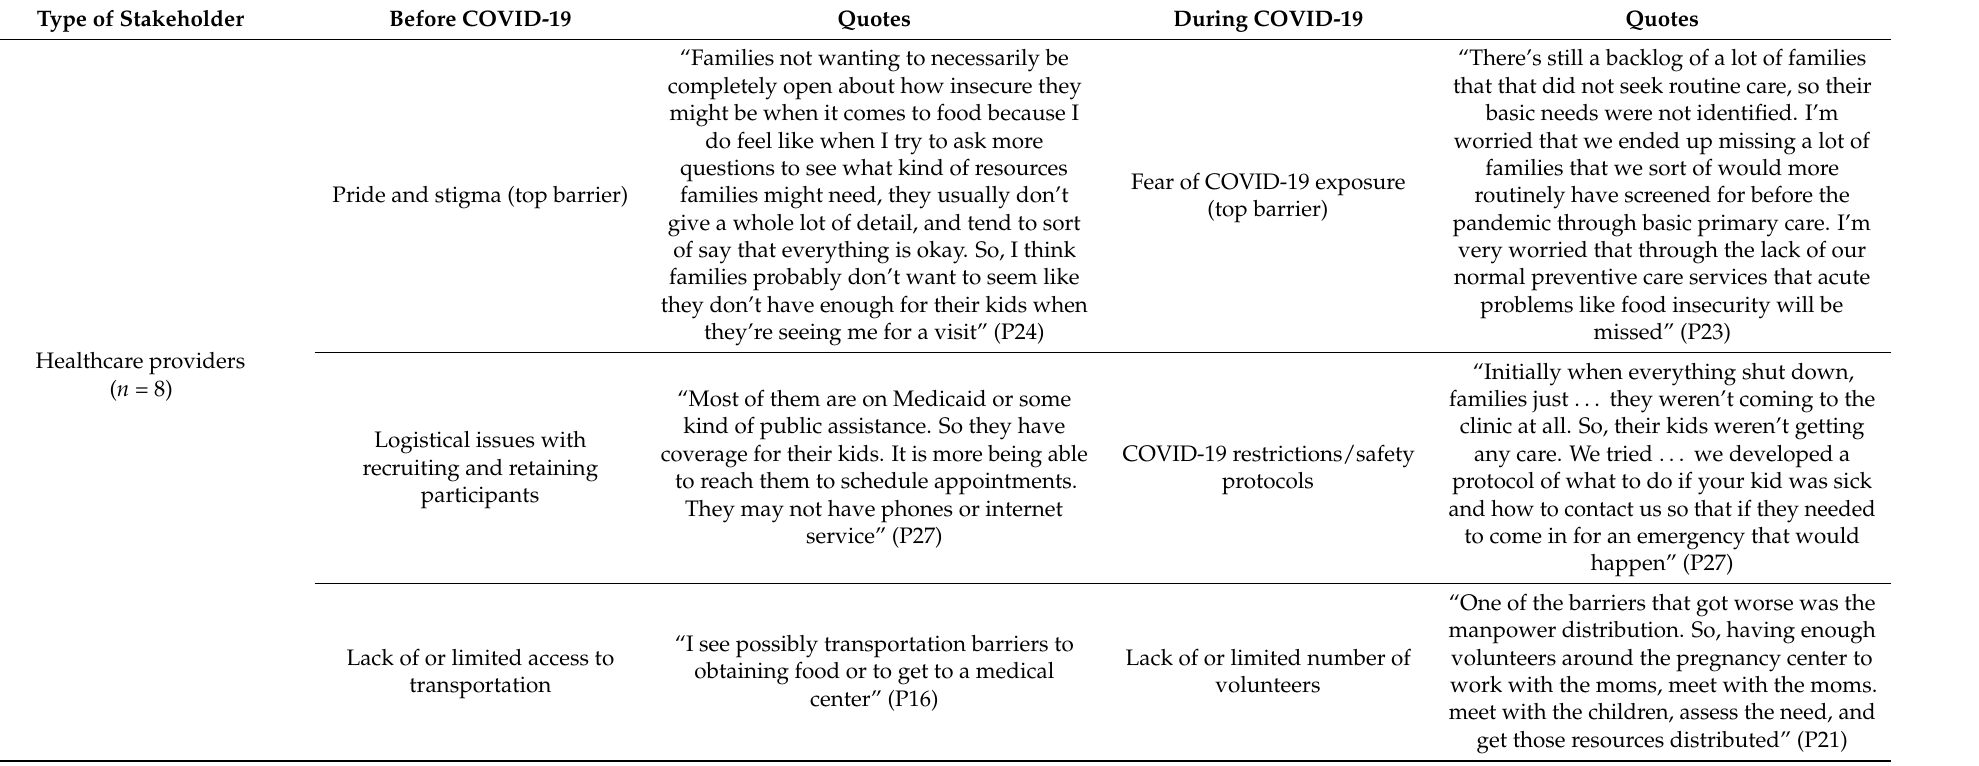
Table 2. Barriers to providing and/or delivering services and/or resources to improve food security among households with children under three before and during the COVID-19